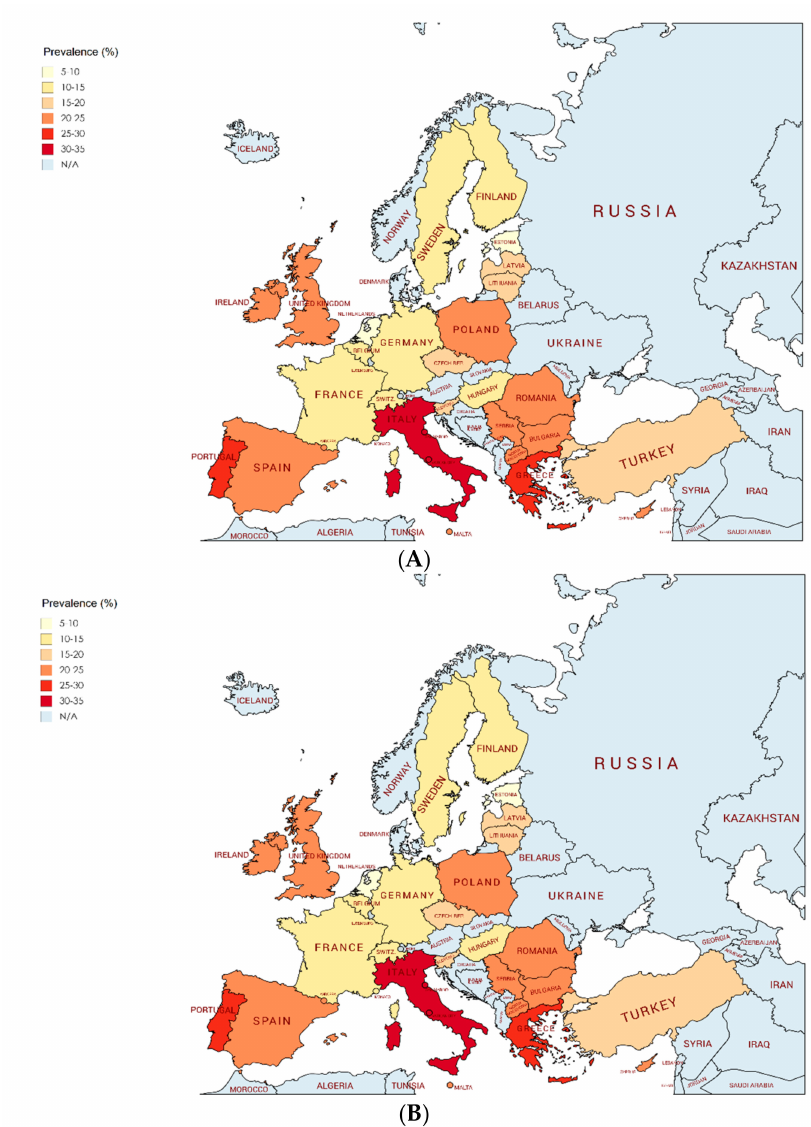
Figure 3. Spatial distribution of the prevalence of overweight / obesity ( A ) and obesity ( B ), based on the IOTF cuto ff s, in European children (aged 2–7 years) from 2006 to 2016. Abbreviations: N / A not